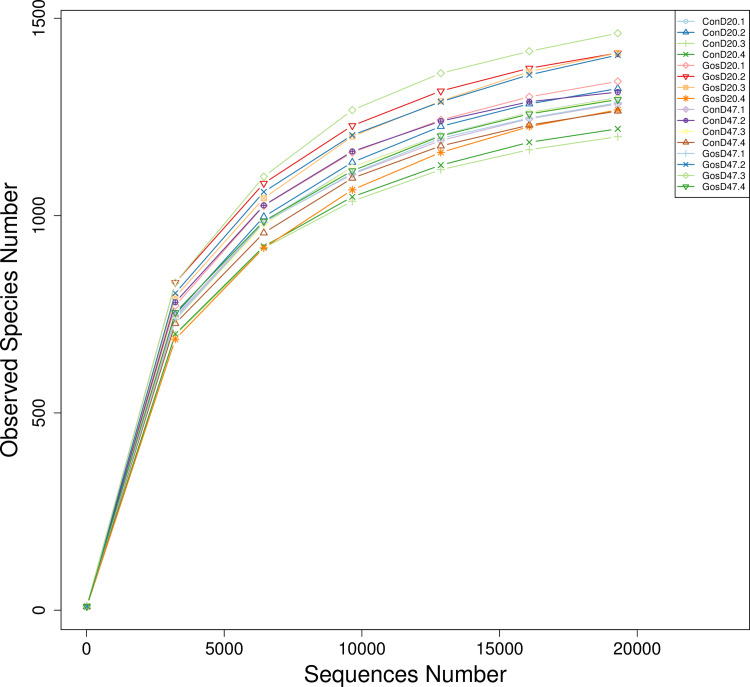
Rarefaction curve of bacteria in the rumen fluid of sheep.